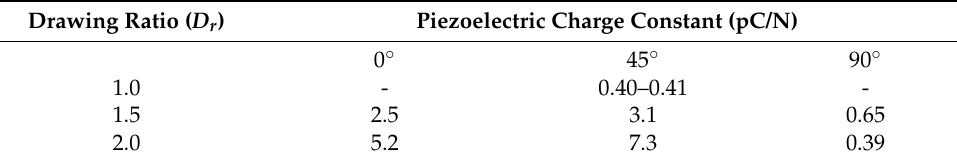
Table 2. Piezoelectric charge constant of dimethylacetamide (DMAC) EAPap [36]. Drawing Ratio ( D r ) Piezoelectric Charge Constant (pC/N)